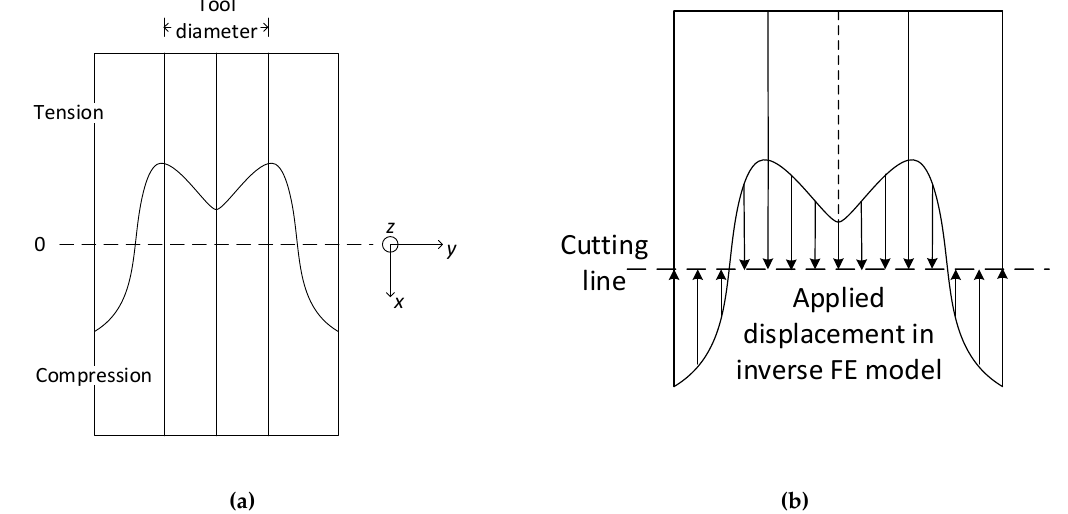
Figure 3. Schematic overview of the contour method concept; ( a ) The friction stir welded (FSW) specimen with longitudinal residual stresses, having the classical M-shape with the maximum around the radius of the tool shoulder; ( b ) Illustration of the deformed shape of the specimen in ( a ) after it has been cut, and the deformations applied in a subsequent inverse finite element (FE) calculation in order to obtain the residual stress field.